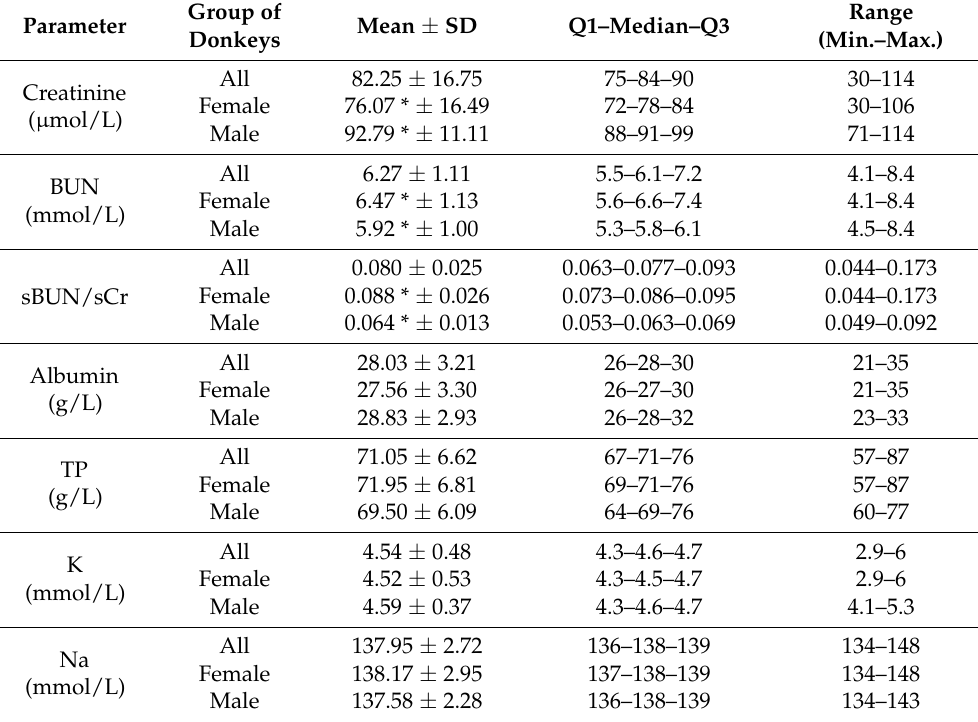
studied healthy donkeys, taking into account gender. Q1—first quartile and Q3—third quartile.